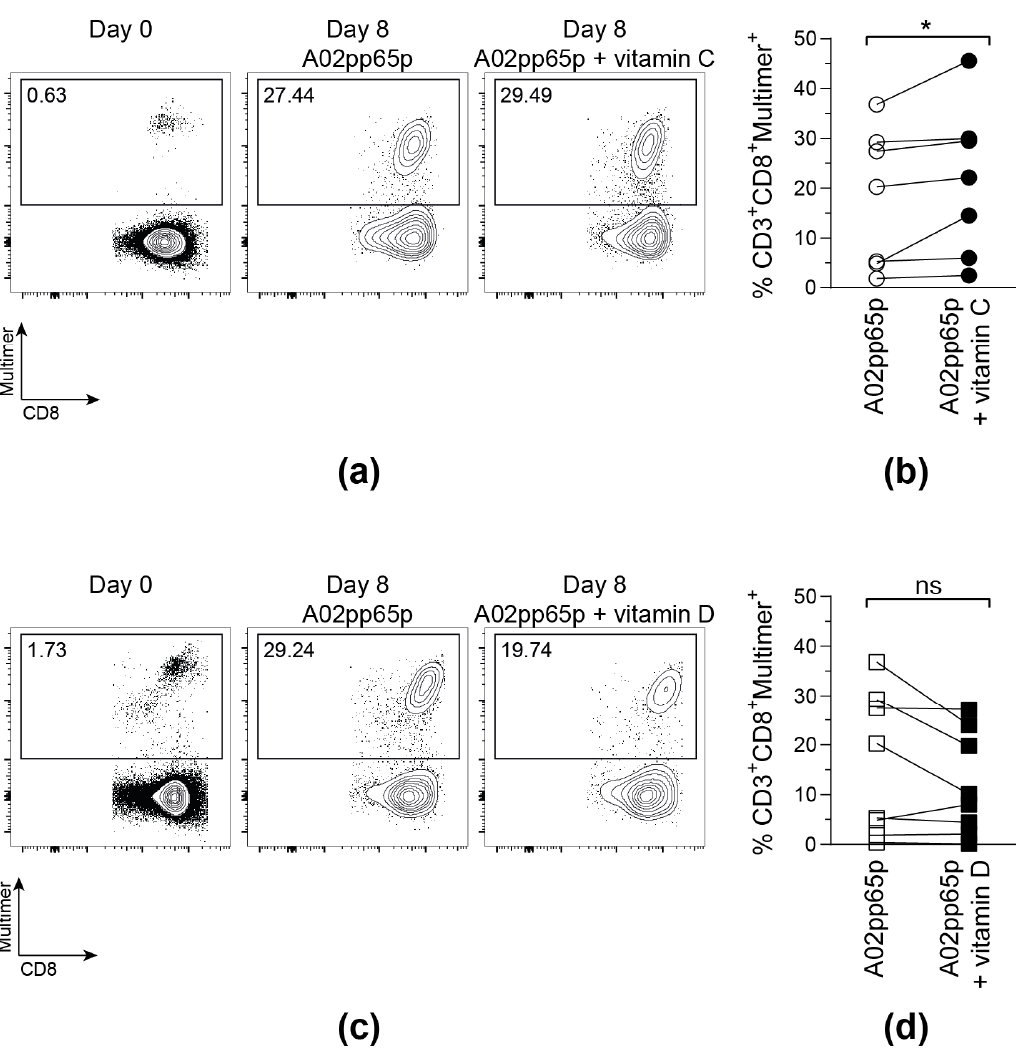
Figure 2. Vitamin C, but not vitamin D, promotes the expansion of A02pp65p-specific cytotoxic T cells. Cells are gated on viable CD8 + T cells based on scatter properties (FSC-A/SSC-A), CD3 and CD8 expression. Shown are exemplary contour plots ( a , c ) as well as summarized frequencies ( b , d ) of HLA-A*02/A02pp65p-specific CD8 + T cells before (Day 0) and after 8 days (Day 8) of stimulation with A02pp65p-loaded aAPCs. ( a , b ) 50 µM vitamin C (A02pp65p + vitamin C); ( c , d ) 500 nM vitamin D (A02pp65p + vitamin D) and without addition of vitamins (A02pp65p). Each point (( b ); n = 7), (( d ); n = 8) represents one donor with lines connecting data from the same donor. Friedman’s test and post hoc Dunn’s test were used to determine statistical significance (* p < 0.05).